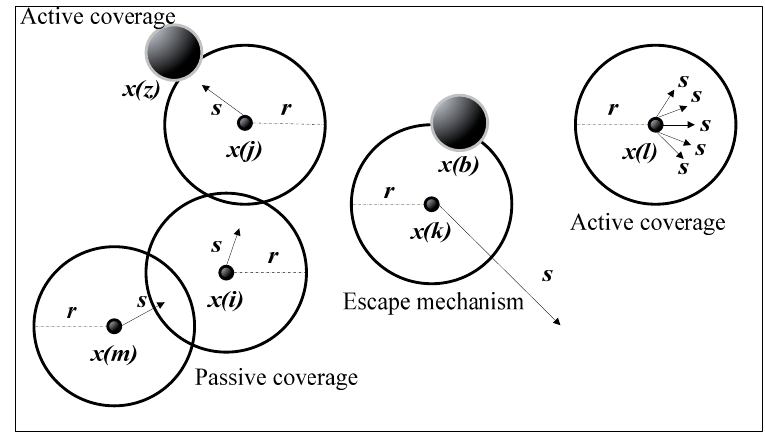
Figure 2. Basic principle diagram of RAWS (redeployment algorithm based on wolf search).